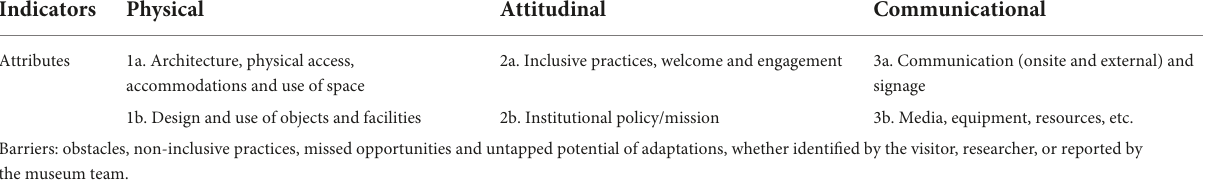
TABLE 2 Framework “Accessibility Indicators of Science